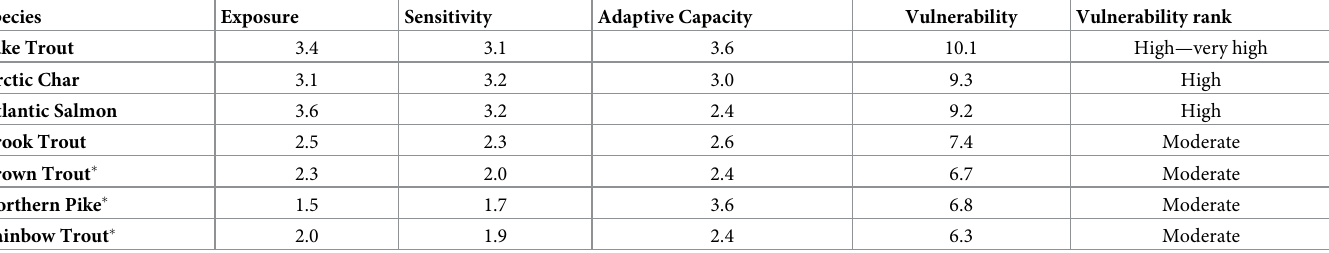
Table 2. Climate change vulnerability scores of selected fishes, from regional fish experts (n = 8). Species are ranked from highest to lowest vulnerability. � indicates non-native species. Exposure, sensitivity and adaptive capacity were calculated using the weighted means of all indicators and applying a logic rule to derive a cumulative vulnerability for all species.